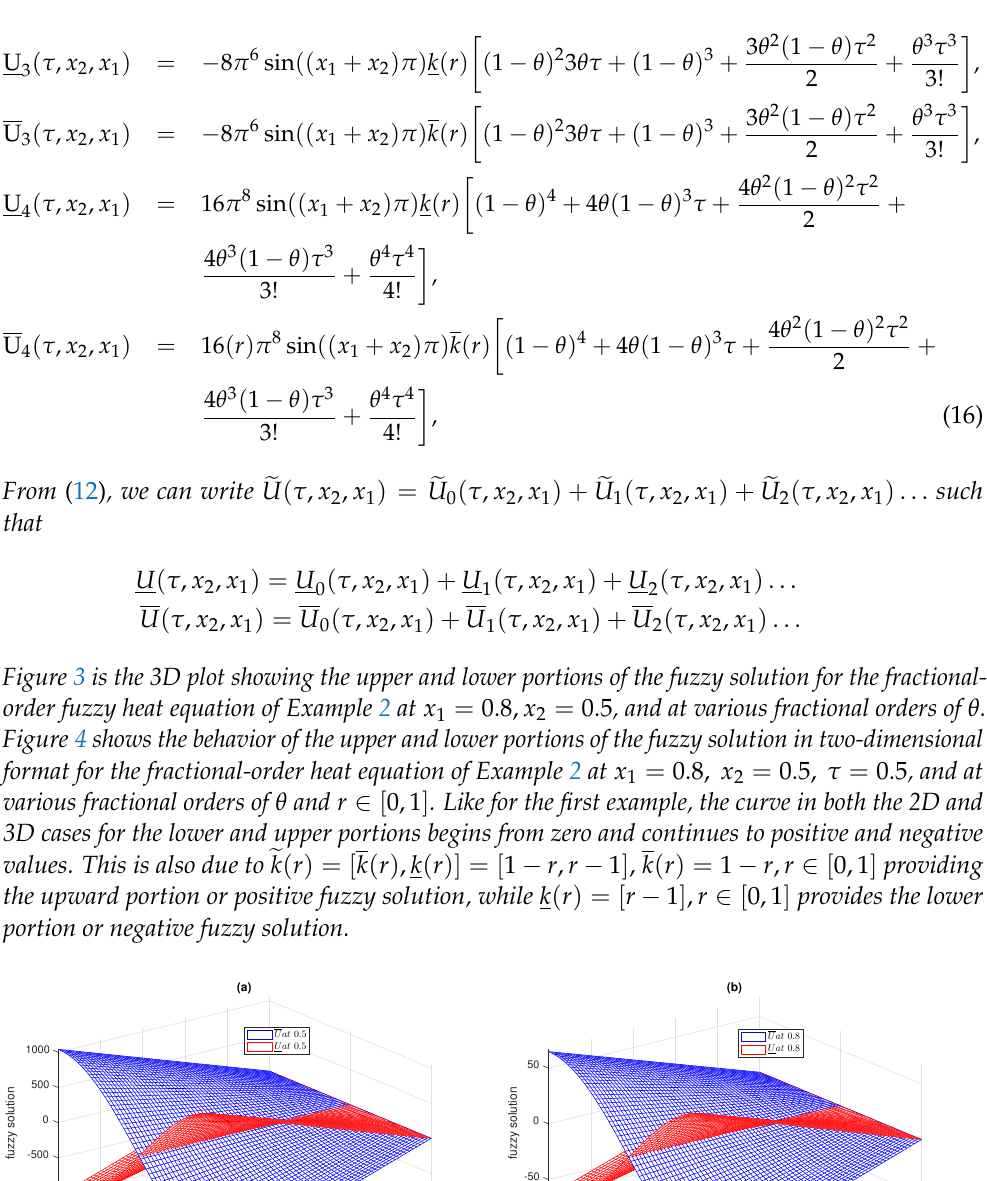
Figure 3. 3-D fuzzy upper and lower portion simulation of semi-analytical series solution up to first four terms at τ = t = 0.5, x 2 = y = 0.5, and at θ = 0.5, 0.8, for Example